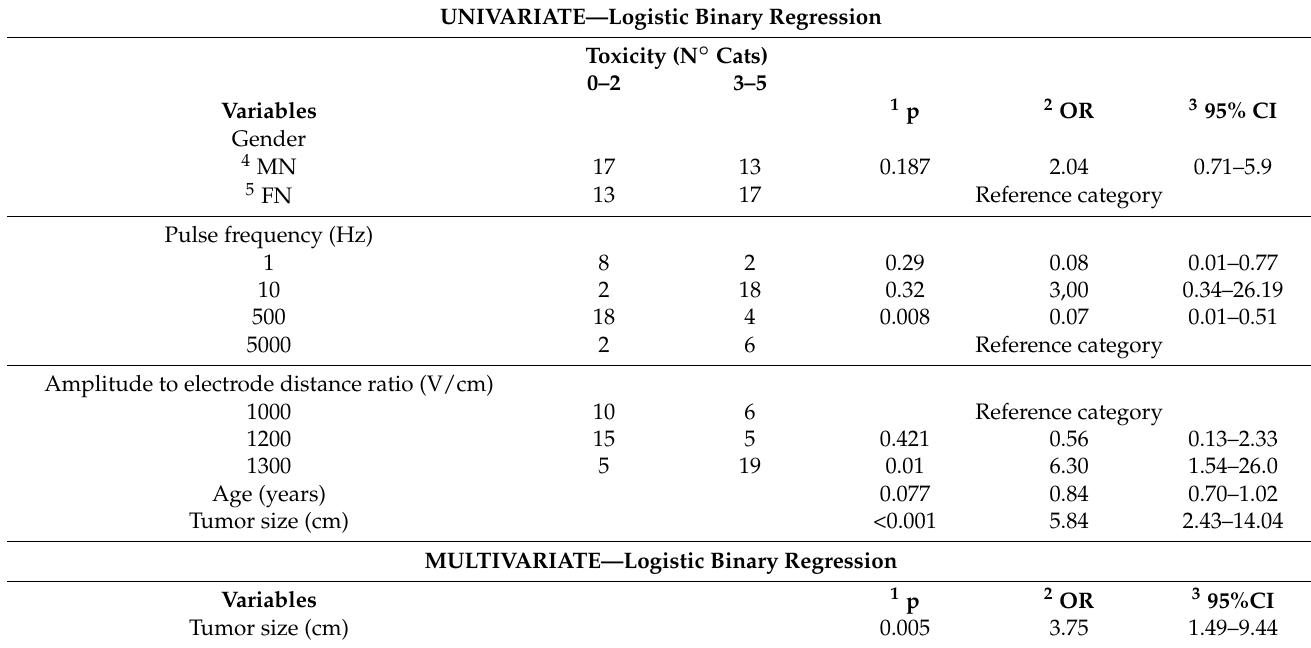
Table 5. Univariate and multivariate analyses for the relationship between variables and toxicity. UNIVARIATE—Logistic Binary